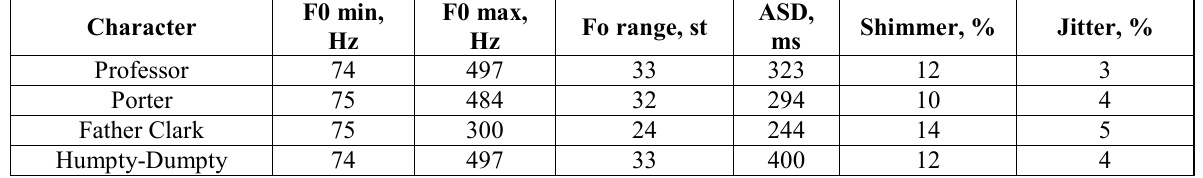
Table 1. Prosodic characteristics of adult male voices